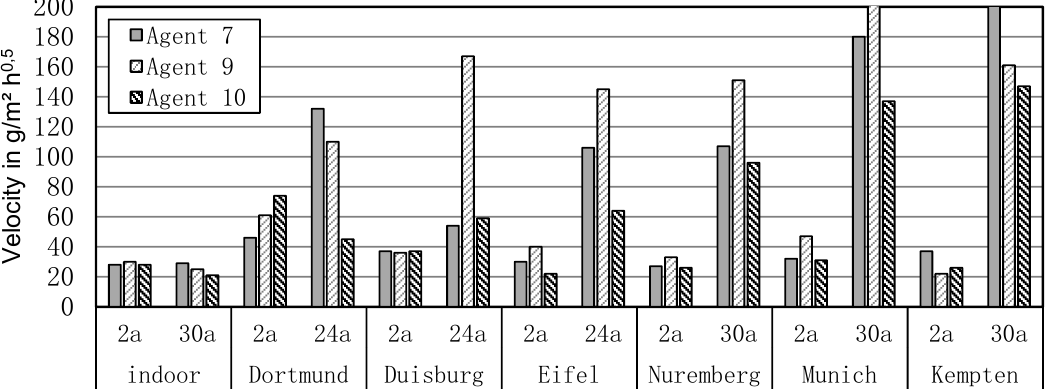
Figure 10. Velocity of water uptake between 5 and 120 minutes for OKS treated with agents 7, 9 and 10 and weathered at the 7 different locations.